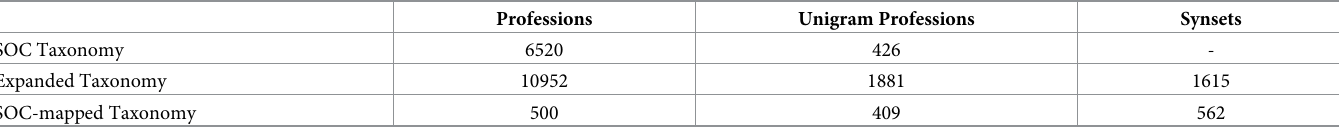
Table 1. Profession taxonomy